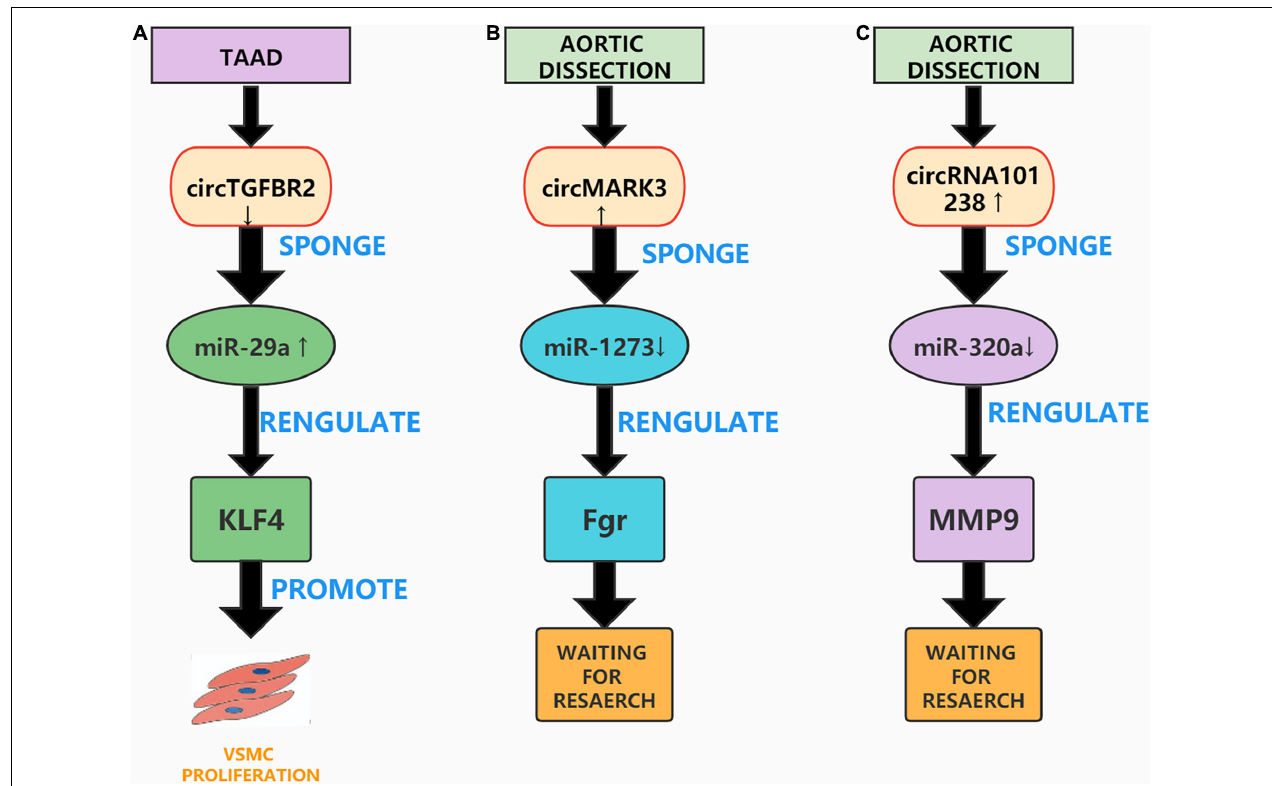
FIGURE 4 | Aortic dissection associated circRNAs. (A) CircTGFBR2 can sponge miR-29a and affect the expression of KLF4 to promote VSMC proliferation. (B) The circMARK3-miR1273-Fgr pathway plays an important role in AD. (C) The circRNA_101238-miR-320a-MMP9 axis may also be concerned in the pathogenesis of